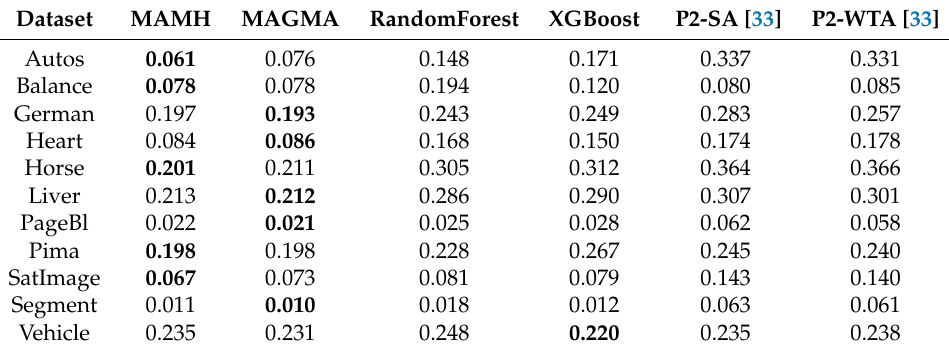
Table 9. The error rate of the hybrid architectures and four recent ensemble